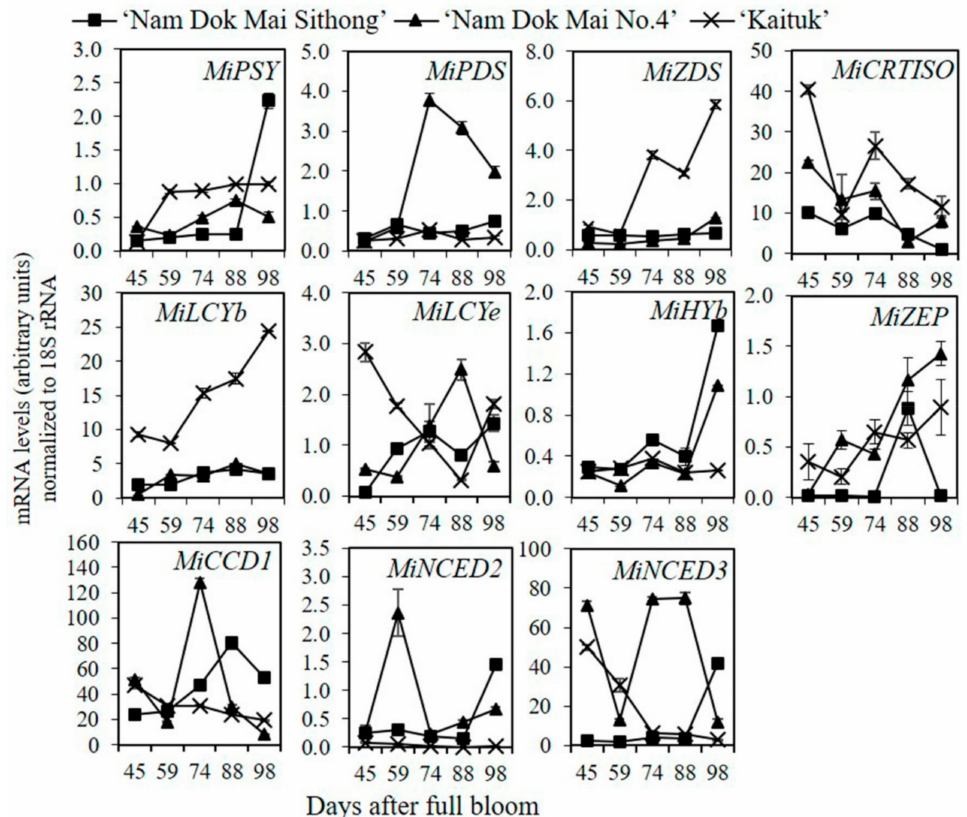
Figure 8. The expression of genes involved in carotenoid metabolism in pulp of mango fruit cv. ‘Nam Dok Mai Sithong’, ‘Nam Dok Mai No. 4’ and ‘Kaituk’ during fruit development (45–88 days) and full ripening stage (98 days). The vertical bars represent the means with SE for three